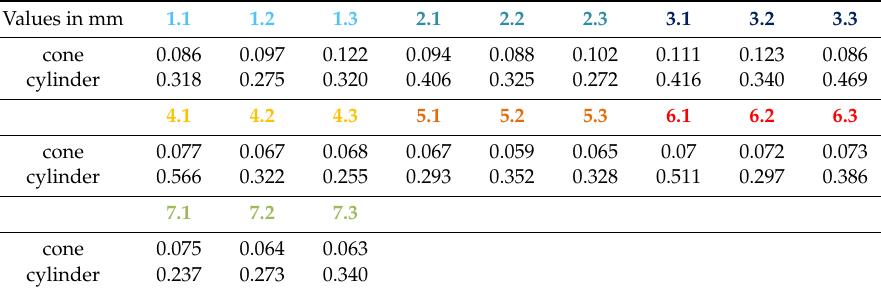
Table 3. Results of shape deviation measurements.